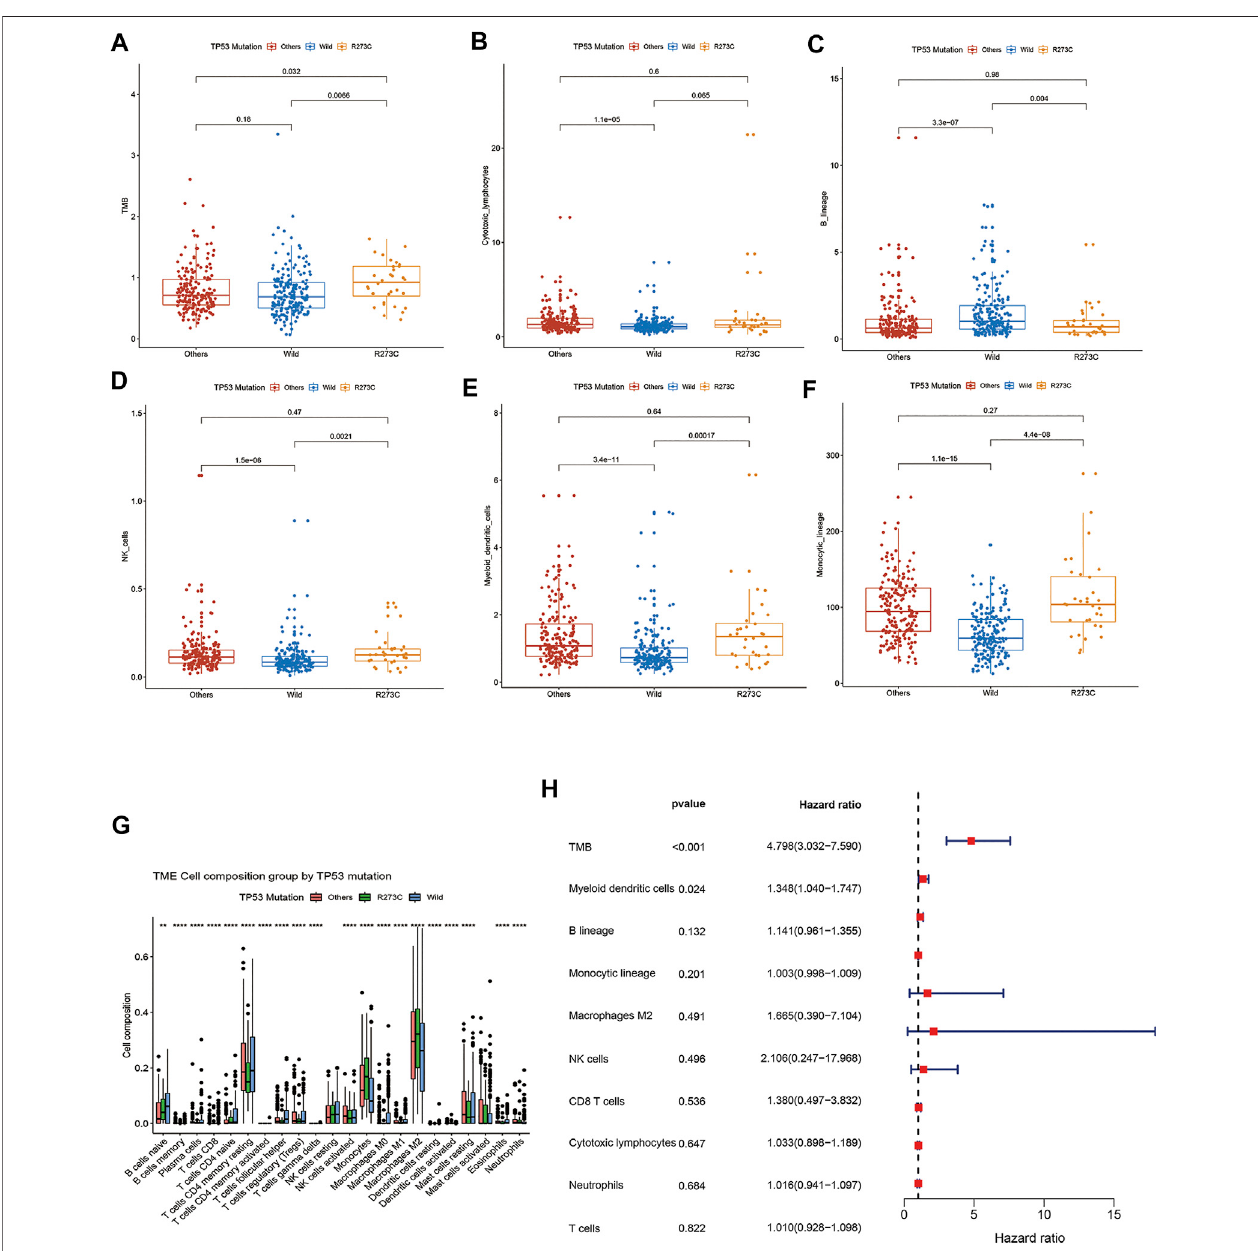
FIGURE 3 | comparison of TMB and immune cell in fi ltration among different groups. (A) TMB, (B) cytotoxic lymphocytes, (C) NK cells, (D) B cells, (E) monocytic lineage cells, (F) myeloid dendritic cells, and (G) Immune cell component comparisons between TP53 mutation and wild-type groups analyzed by CIBERSORT. (H) Forest plot of univariate Cox proportional hazards regression analysis of overall